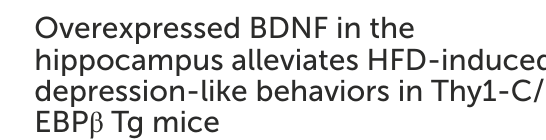
Figure 7I). These results confirmed that overexpression of BDNF in hippocampus alleviated HFD-induced depression-like behaviors in Thy1-C/EBP β Tg